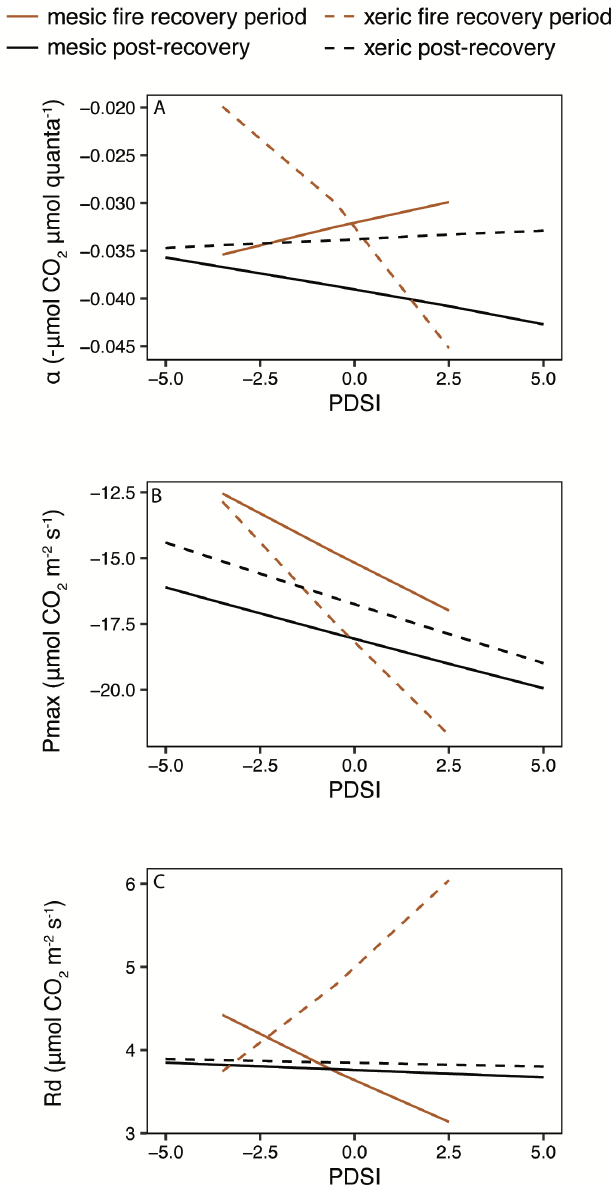
Figure 3. Least square mean estimated light response parameter values for fire recovery period and post-recovery by site: ( A ) Apparent quantum efficiency ( α ), ( B ) maximum ecosystem CO 2 uptake rate ( P max ), and ( C ) ecosystem respiration ( R d ).